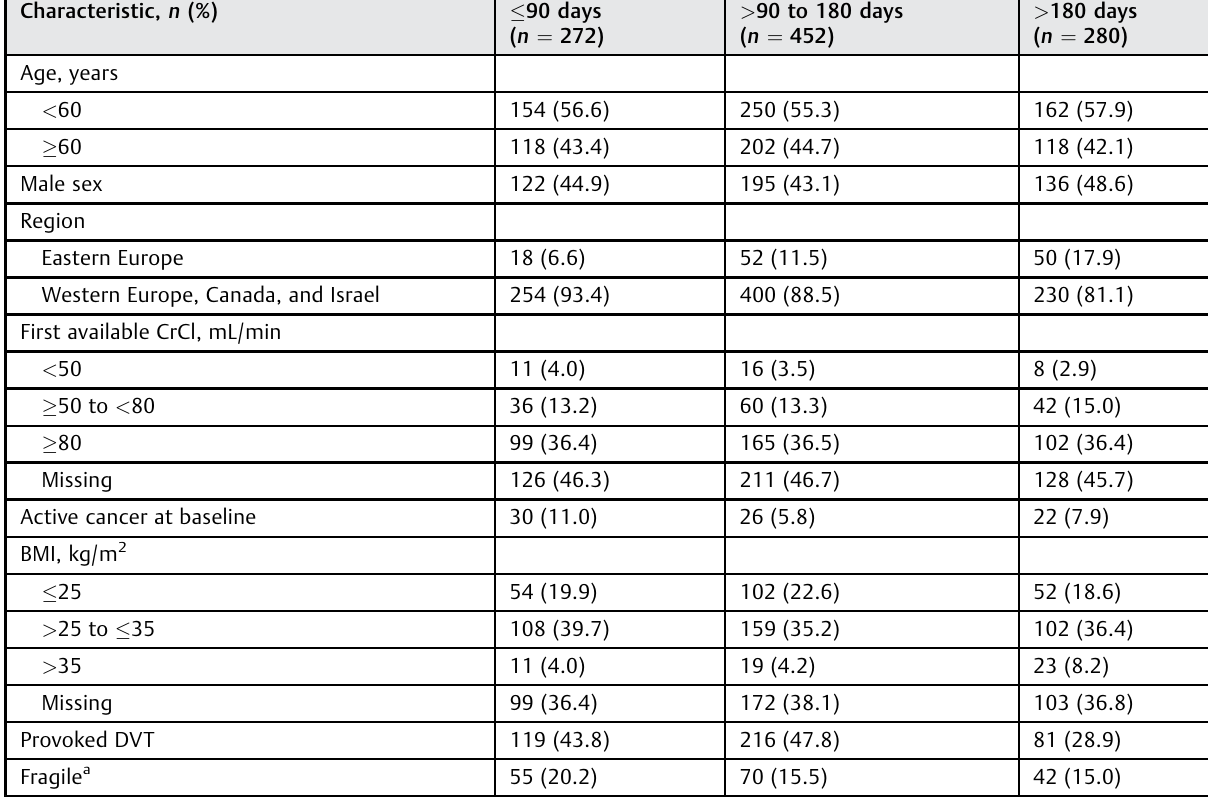
Table 2 Baseline demographics and clinical characteristics of patients with IDDVT in the safety analysis set by treatment duration Characteristic, n